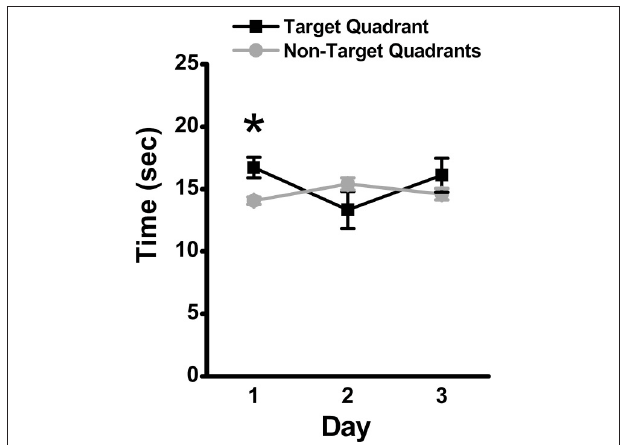
FIGURE 3 | Memory retention in the MWM assessed by time in target quadrant. During the 3-day retention phase, the platform was removed, and the time spent in the target quadrant was compared to the average time spent in the non-target quadrants. Mean ± SEM; n = 10 ; * p < 0.05 .